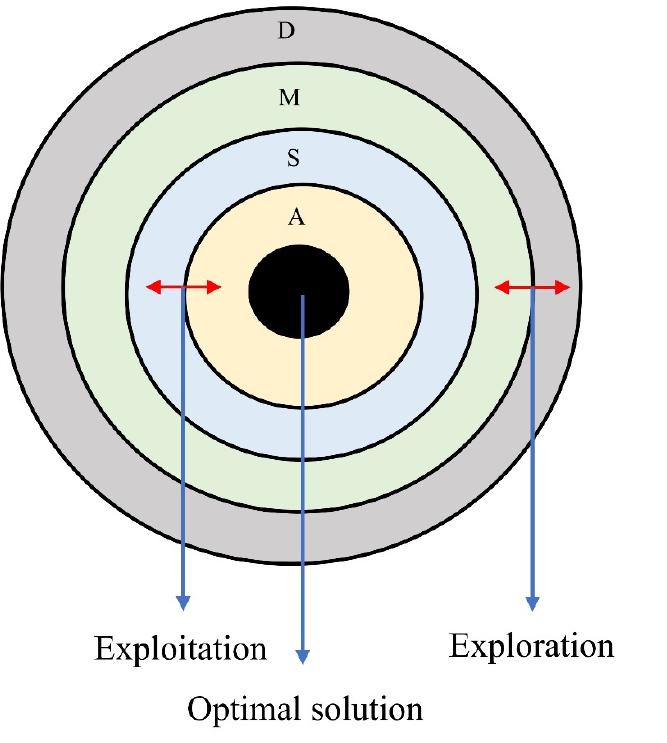
Figure 1. Hierarchy of AOs in AOA with exploration and operation phases adopted from